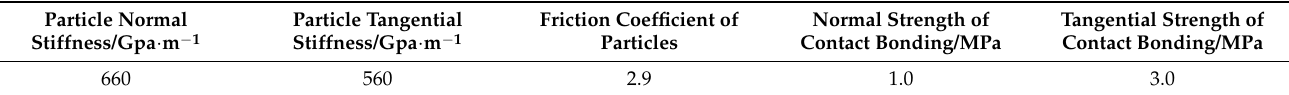
Table 5. Micro-parameters of bedded